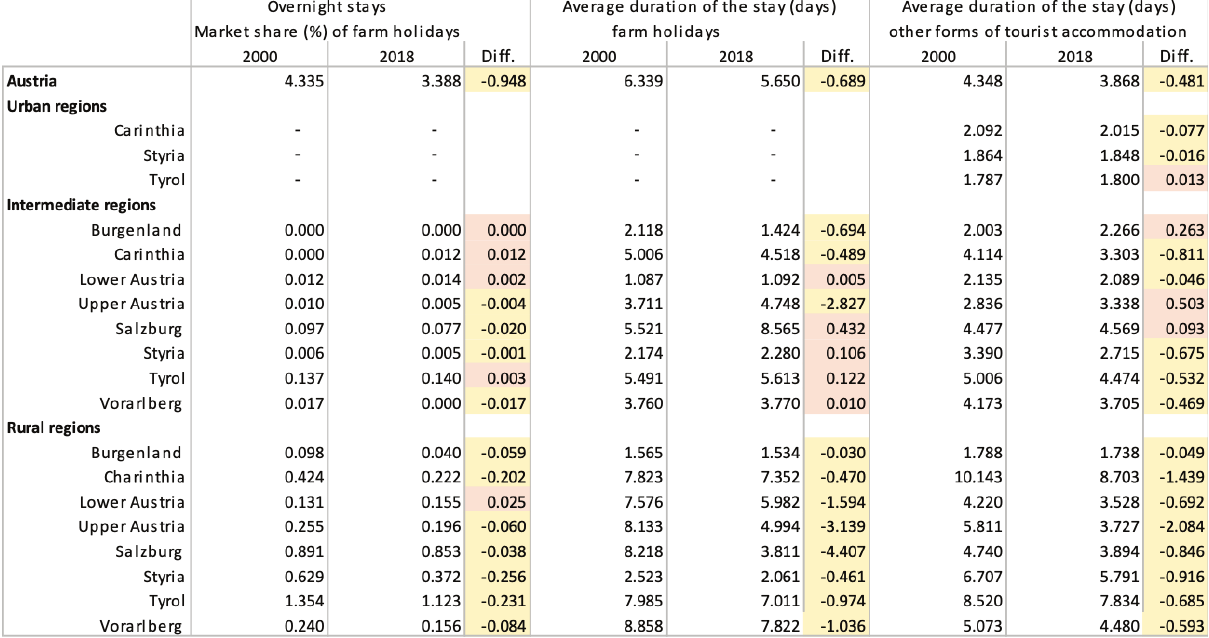
holiday is six days and four days in the case of ‘other forms of tourist accommodation’. Although in Austria hol- Table 3: Market share of farm holidays in terms of the number of overnight stays and the average duration of the stay (in days) for farm holidays and ‘other forms of tourist accommodation’ by NUTS3 regions (Statistics Austria